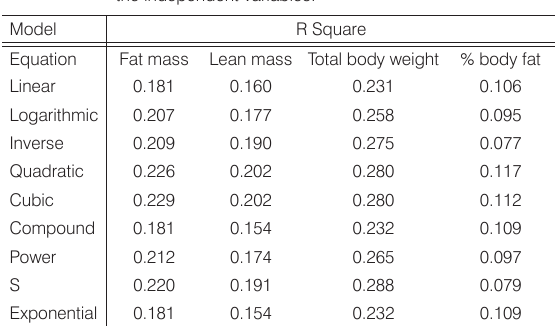
The significance was p<0.001 for all equations including body weight, fat and lean mass, and 0.01 > p > 0.001 - for the% body fat.